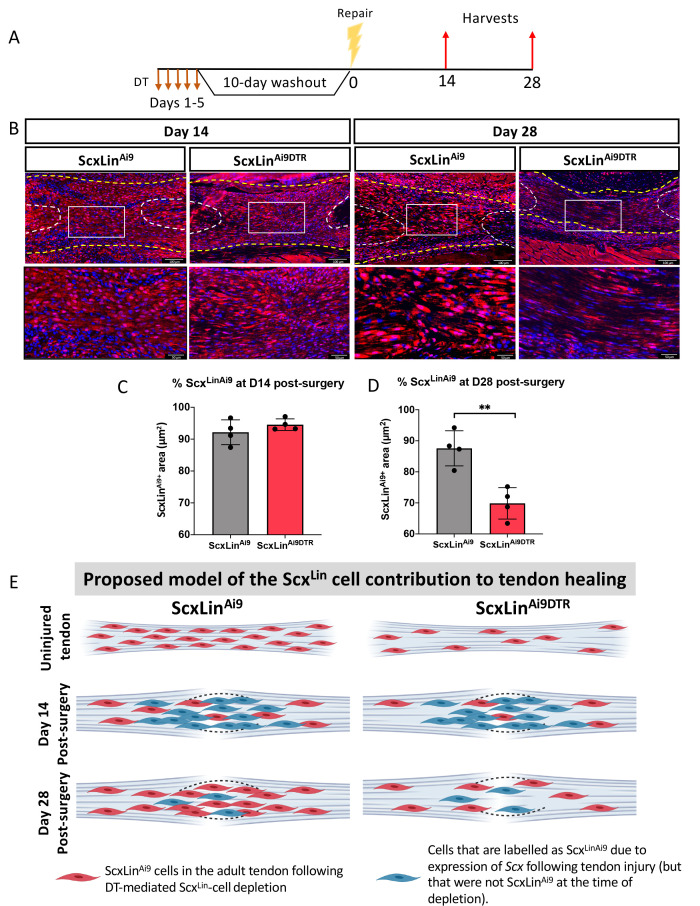
ScxLin cell depletion results in time-dependent changes in ScxLinAi9 cell presence during tendon healing.(A) Mice received hind paw injections of DT on 5 consecutive days, underwent flexor tendon repair surgery 10 days after the final DT injection, and were harvested at 14 and 28 days post-repair. (B) Immunofluorescence for RFP (Ai9) in WT ScxLinAi9 and ScxLinAi9DTR tendon repairs at 14 and 28 days post-repair to define changes in ScxLinAi9 contribution following ScxLin cell depletion. Quantification of ScxLinAi9+ area in ScxLinAi9 WT repairs and ScxLinAi9DTR repairs at (C) D14 and (D) D28 post-surgery. Nuclei were stained with DAPI. N = 4 per genotype. Student’s t-test used to assess statistical significance between genotypes at a given timepoint. **indicates p<0.01. (E) Proposed model of the time-dependent contributions of ScxLinAi9 cells to the tendon healing process. During adult tendon homeostasis ScxLinAi9 cells are the predominant tenocyte population and ScxLinAi9DTR results in depletion of ~60% of these cells. Red cells indicate ScxLinAi9 cells that were present in the tendon when depletion was initiated. We hypothesize that no differences in the proportion of ScxLinAi9 cells is observed at D14 (concomitant with a lack of functional phenotypic differences) due to the predominance and functions of other cell populations, including those that express Scx in response to injury and are therefore labeled as ScxLin (blue cells). In contrast, we hypothesize that by D28 the contribution of ‘new’ ScxLin cells (blue cells) has waned, and that the ScxLinAi9 cells that were present in the tendon during adult tendon homeostasis (red cells) are now the predominant tenocyte population and exert their functions at this time as suggested by functional differences between WT and ScxLinDTR at this time. This schematic was made using http://www.biorender.com.